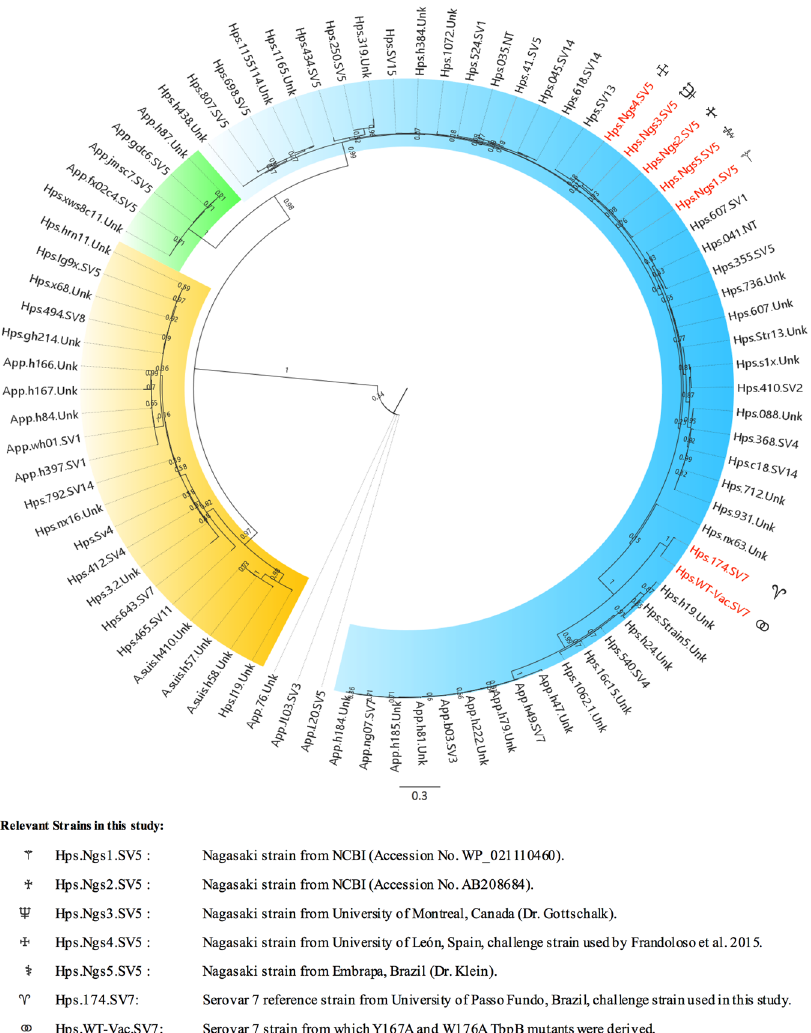
Figure 1. Sequence diversity of TbpBs from porcine pathogens. Maximum likelihood tree demonstrating the overall diversity of TbpBs from H. parasuis, A. pleuropneumoniae and A. suis . Leaf labels identify the strains from which TbpB sequences were obtained and indicate their species and serovar, if known (NT = Nontypeable, Unk = Unknown). The sequences are rooted by the three sequences with a white background, which are the secondary TbpB-like genes. Sequences of interest to this study are labelled in red. The sequences clustered into three main groups (Group 1 = yellow background, Group 2 = green background, Group 3 = blue background) with high confidence. The branch support values are